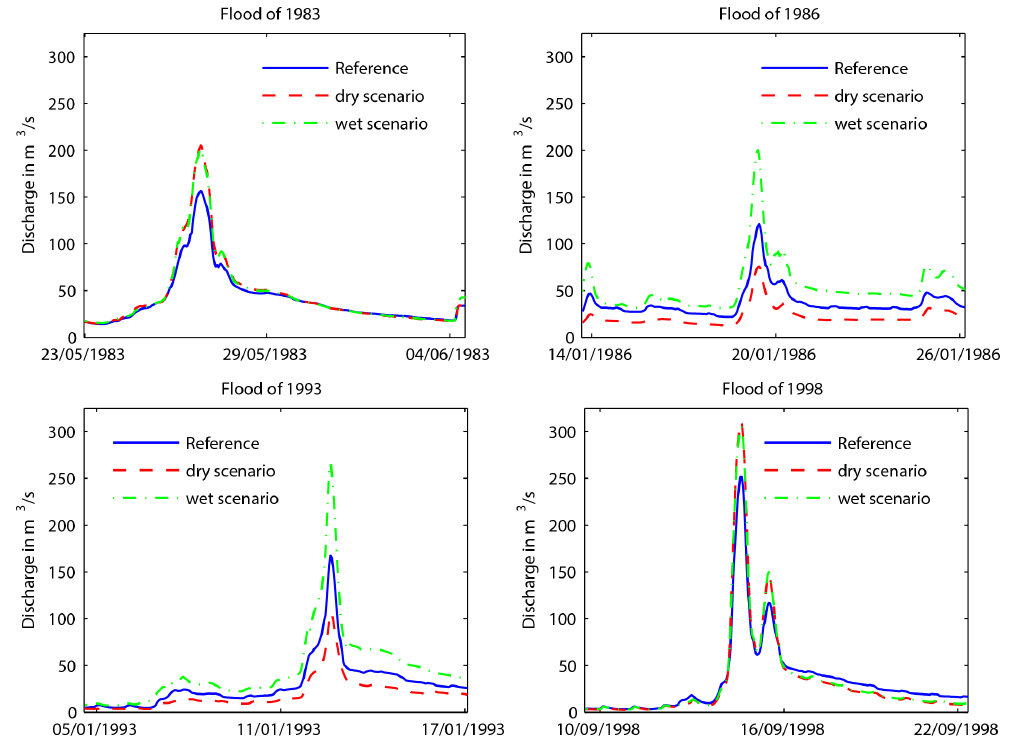
Figure 7. Flood hydrographs in Chaudfontaine (lower reach) for four major floods in the present situation and in the time period 2070–2100.